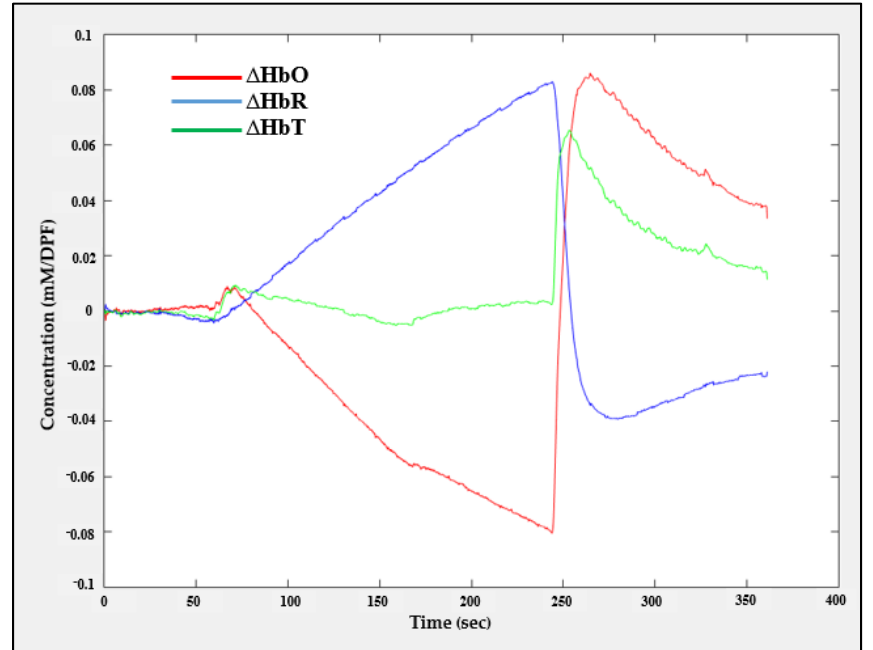
Figure 18. Hemodynamic responses recorded from channel one (CH1) during the arterial occlusion experiment.